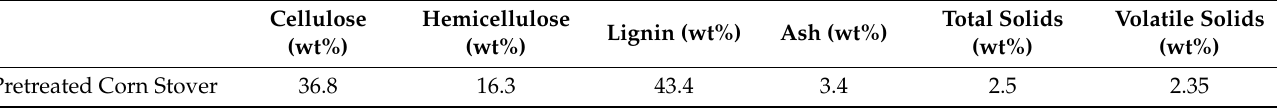
Table 1. Compositional data for pretreated (wet exploded) corn stover